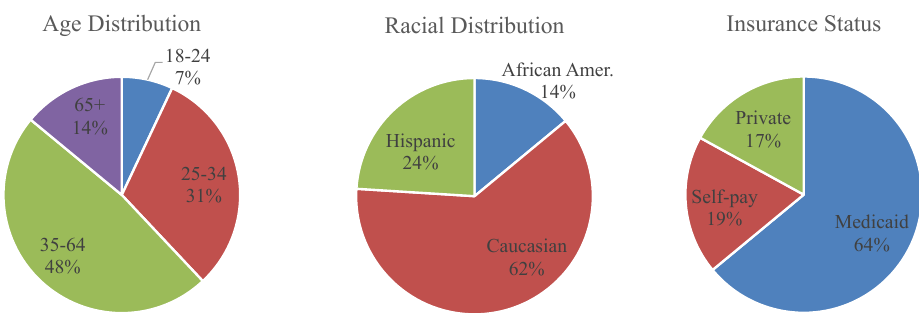
Figure 1 . Age, Race, and Insurance Status for Patient Participants